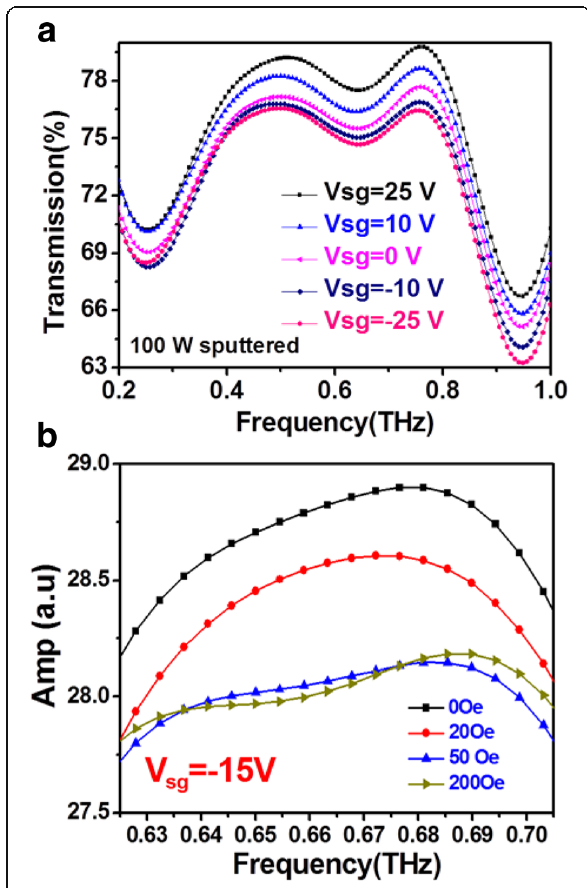
Fig. 5 THz characterization. ( a ) The spectrum of THz transmittance from 0.2 to 1.0 THz at different gate voltages from − 25 to 25 V, and ( b ) the frequency domain spectrum under different external magnetic field from 0.63 to 0.70